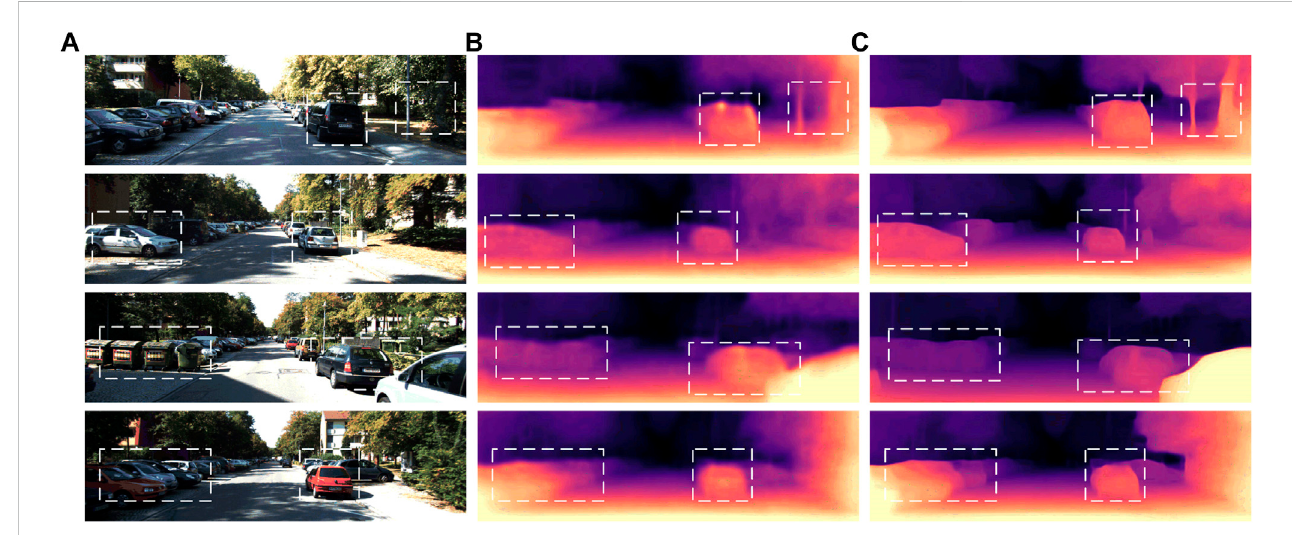
FIGURE 10 Comparativeexperimentalresultsofmulti-scalereceptive fi eldRFBvisualizationonKITTIdataset: (A) Thecolorimagesinputbythemodel; (B) Thedepth map results predicted by Zhou et al.; (C) The depth map results predicted by ACResNet50+ RFB structure.